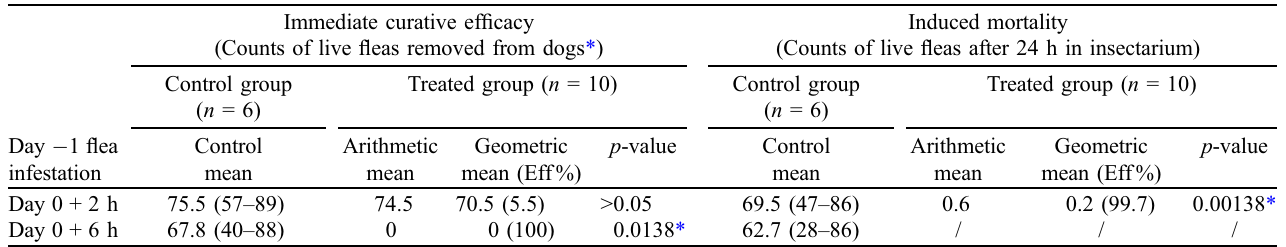
* The live fleas removed from dogs were put in the insectarium for 24 h. Induced mortality was evaluated as the survival of fleas measured in the insectarium after 24 h.